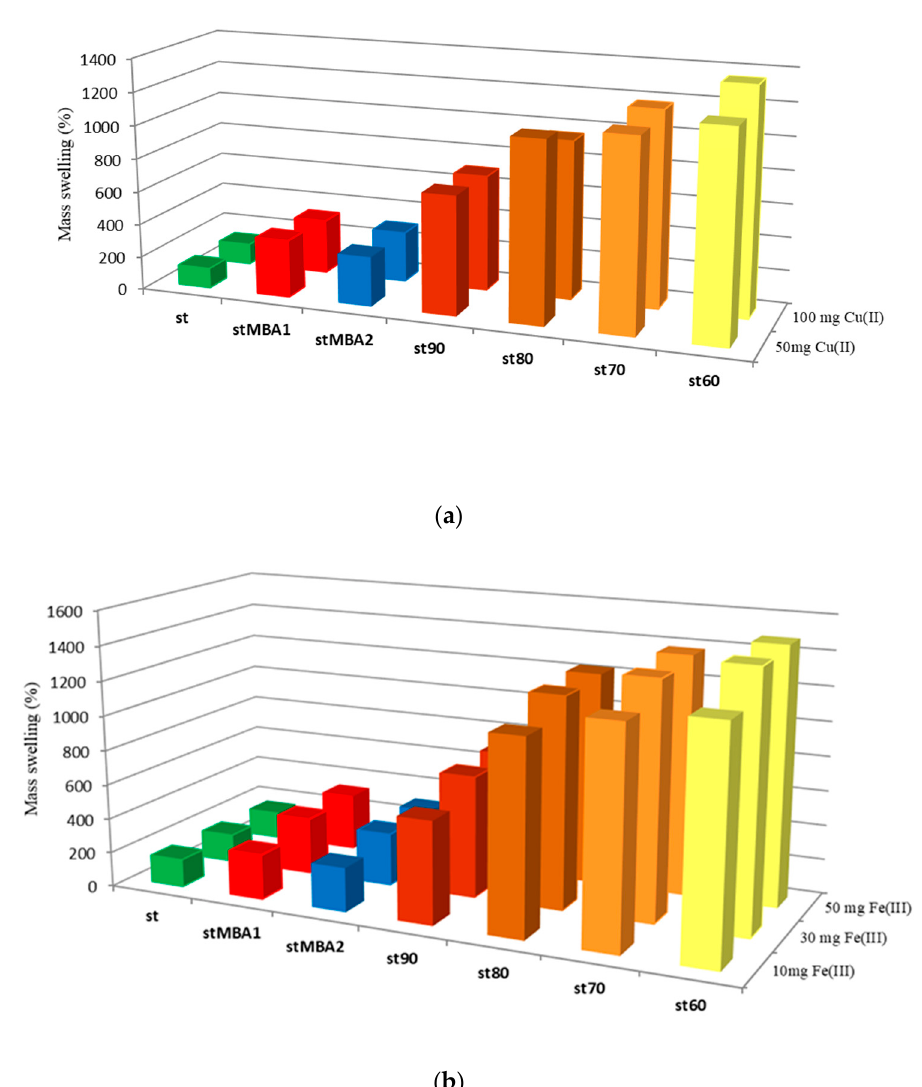
Figure 10. Mass swelling of potato starch (St) and cross-linked starches (StMBA1 and StMBA2) and cross-linked starch-g-polyacrylamide absorbents with di ff erent amount of natural polymer St90, St80, St70, St60 after 48 h in ( a ) Cu(II) solutions; ( b ) Fe(III)